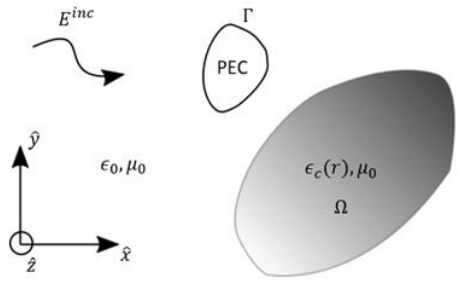
Figure 1. Description of the 3D scattering problem. The perfectly electric conducting (PEC) parts are modeled by their boundary (i.e., Γ ) and the dielectric parts are modeled by their volume (i.e., Ω